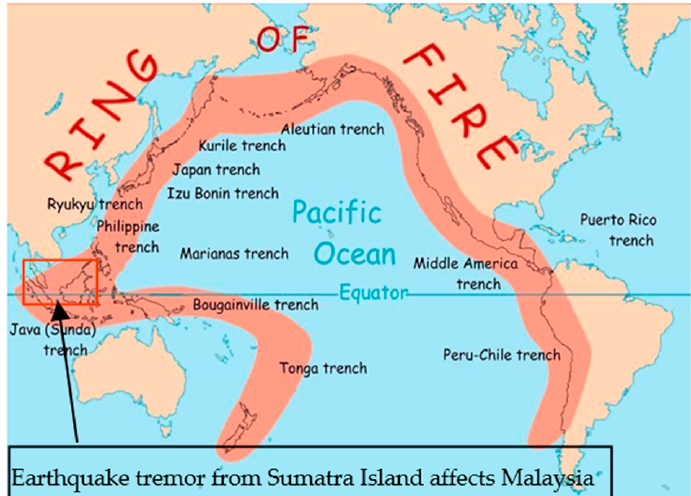
Figure 1. Ring of fire, covering Malaysia.